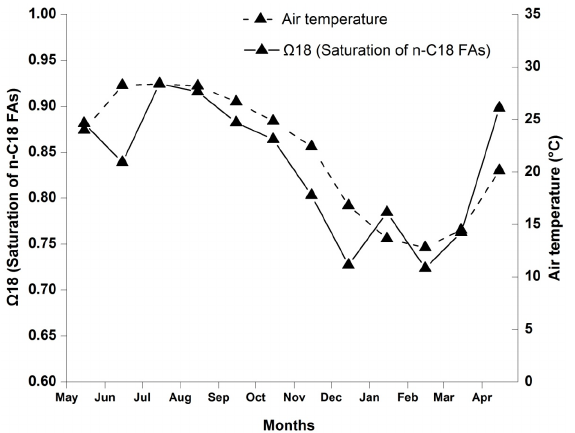
Figure 8. Temporal variations in the saturation of n -C 18 FA homologs ( Ω 18 ) of ambient air aerosols (the solid line) and the monthly average air temperature (the dashed line) in south coastal Xiamen. Ω 18 = [C 18:1 − C 18:3 ]/[C 18:1 + C 18:2 + C 18:3 ].